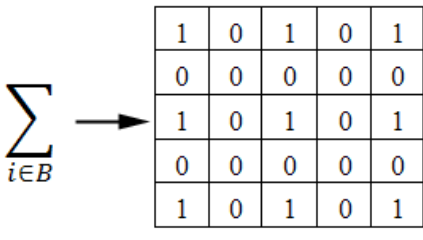
Figure 1. 5 × 5 Sparse Integration Block (SIB)